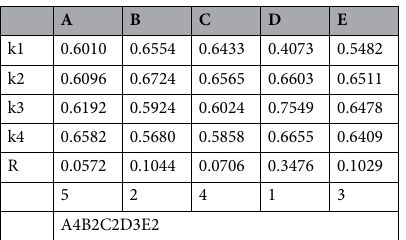
Table 9. Grey correlation range analysis of comprehensive evaluation.